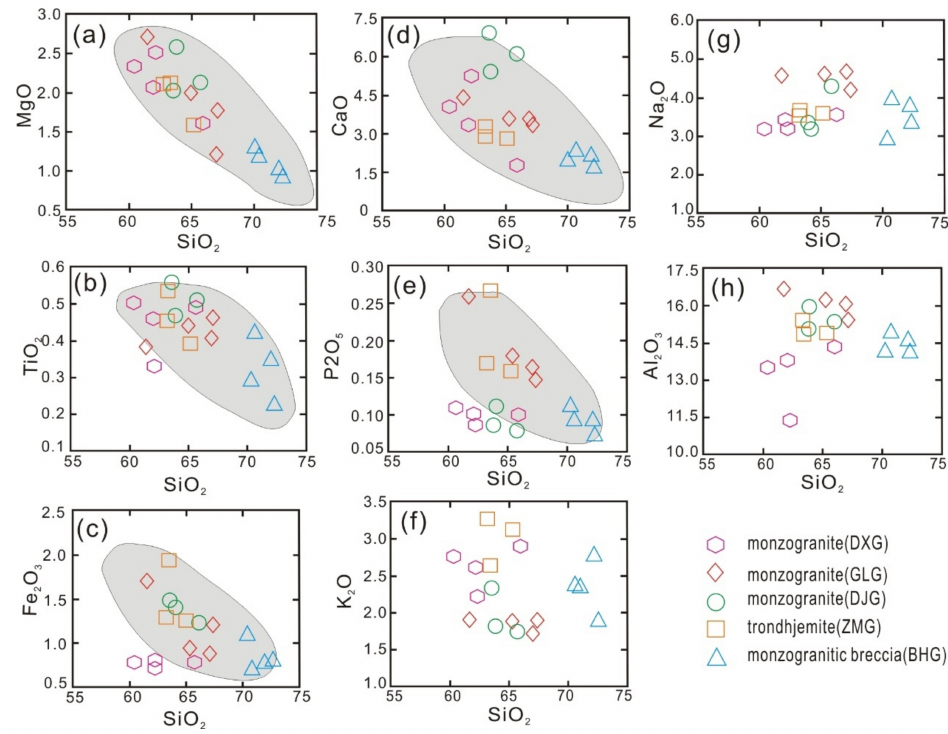
Figure 8. Harker variation diagrams for the TTG gneisses in the Liuhe